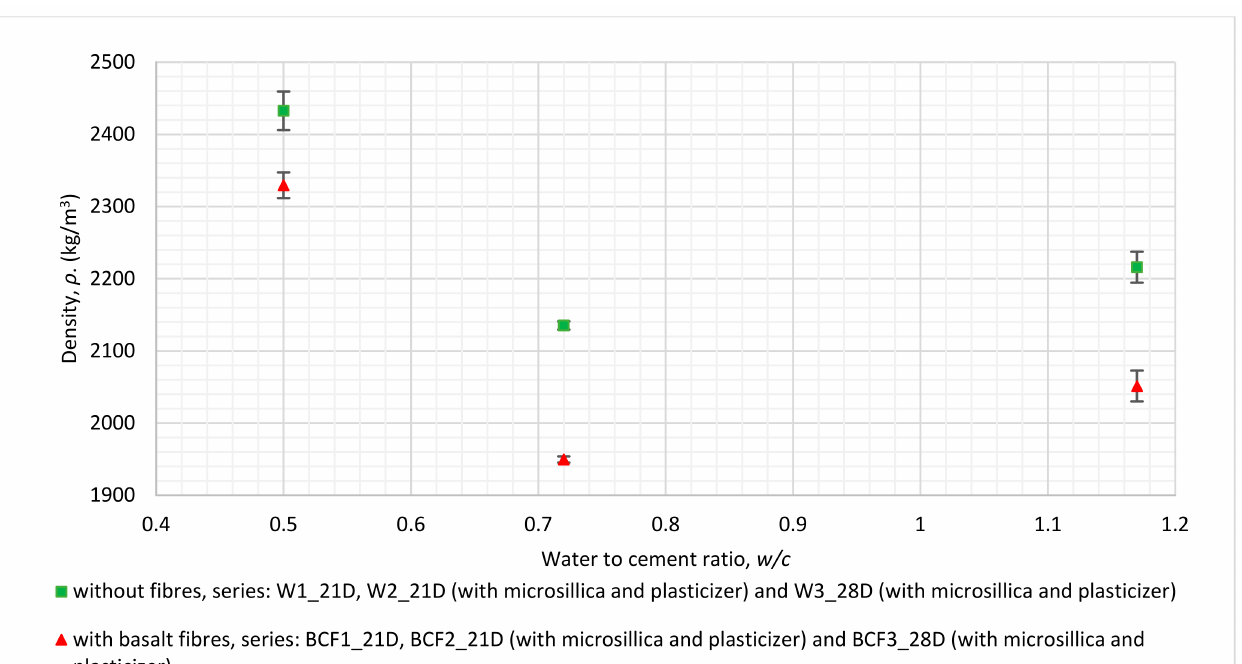
Figure 5. Relation between w/c ratio and density for series revealing the influence of mixture proportions (for detailed descriptions of mixture proportions, see Table